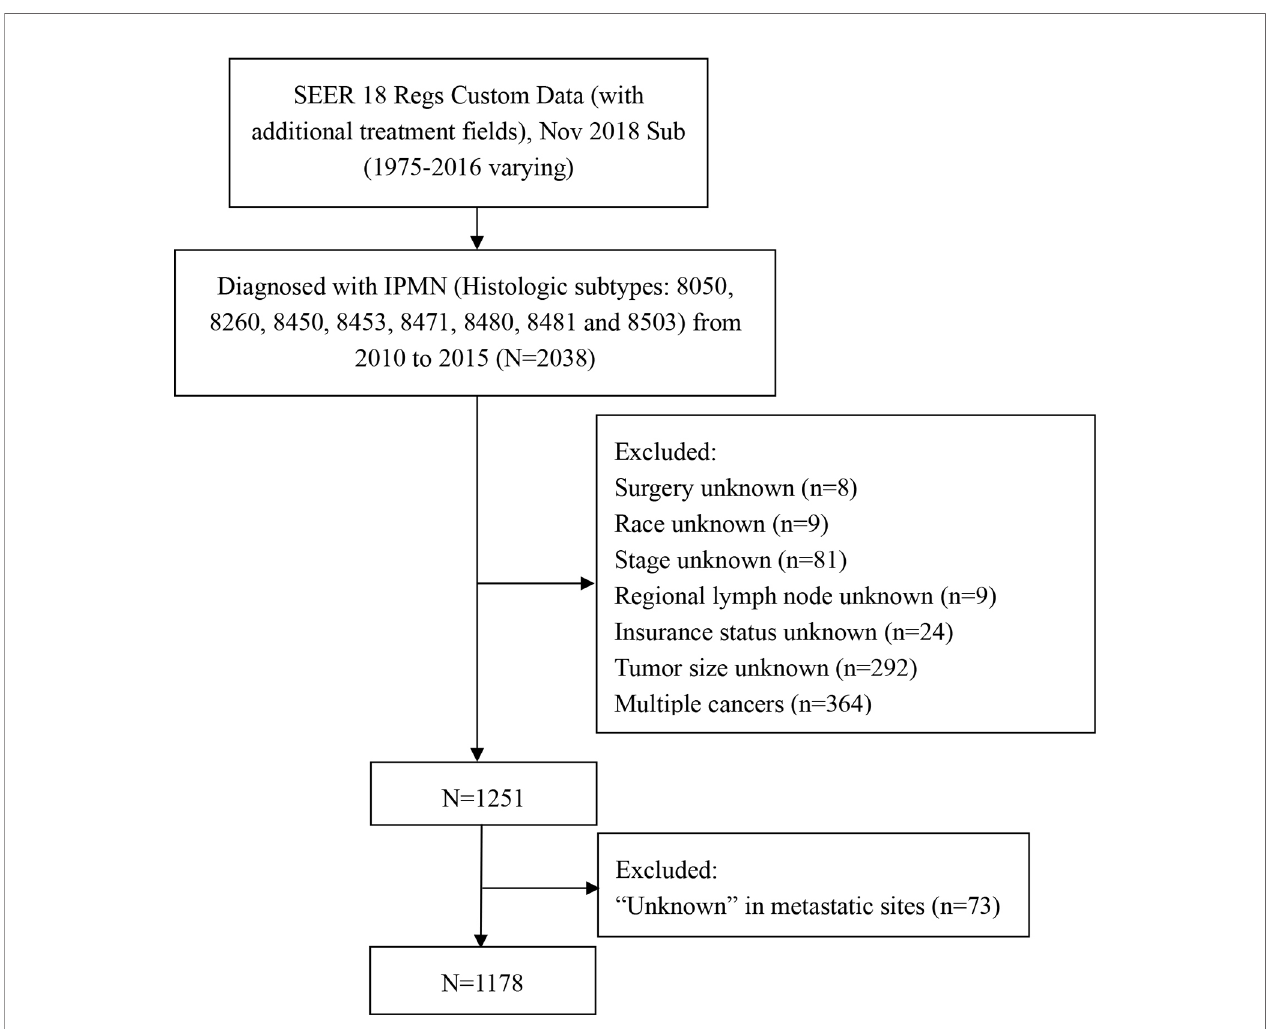
FIGURE 1 | The fl ow chart of eligible patients ’ selection in this